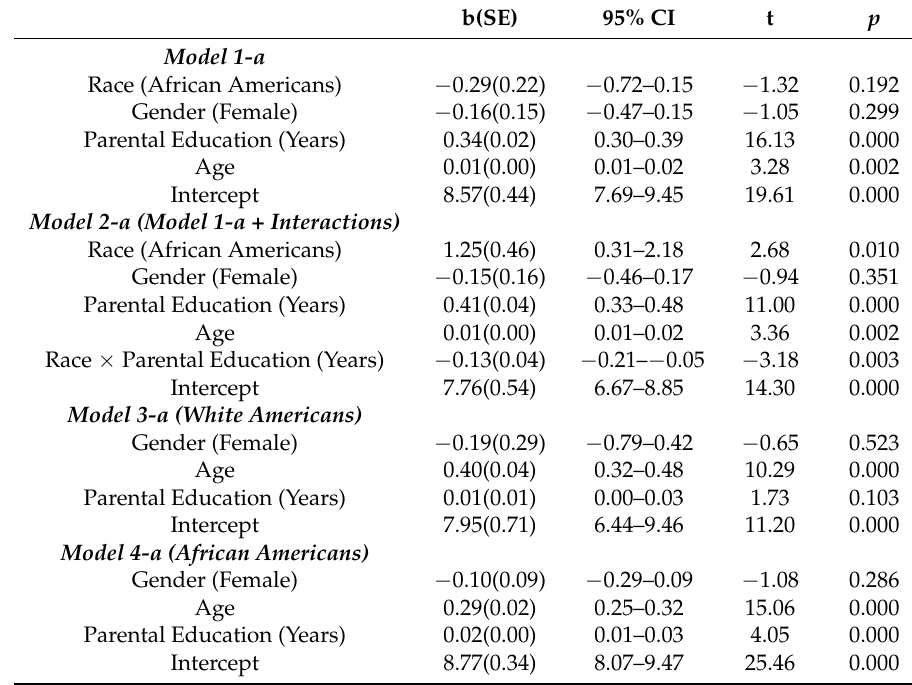
Table 2. Linear regressions between race, parental education attainment, and upward educational mobility.